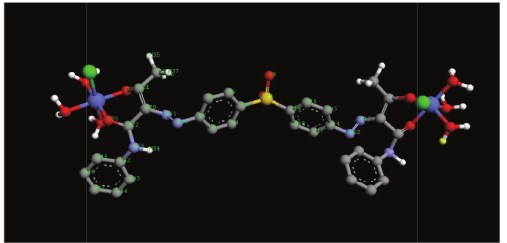
Figure 4: Optimised geometry of [Co 2 L 󸀠 Cl 2 (H 2 O) 6 ]